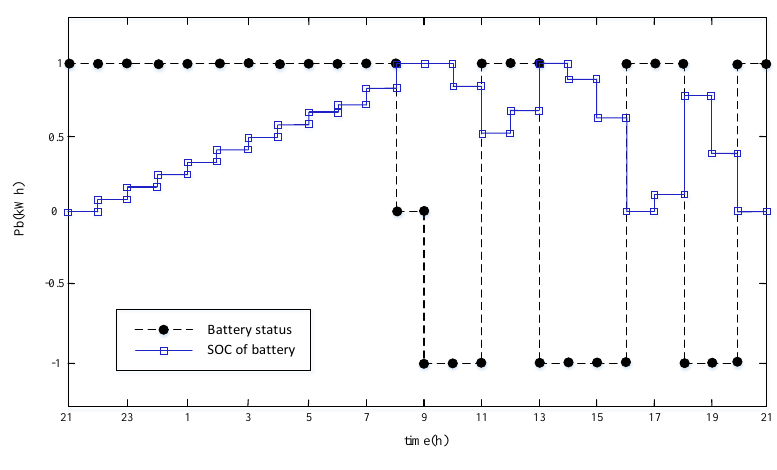
Figure 13. Output heat of the electric heating boiler.